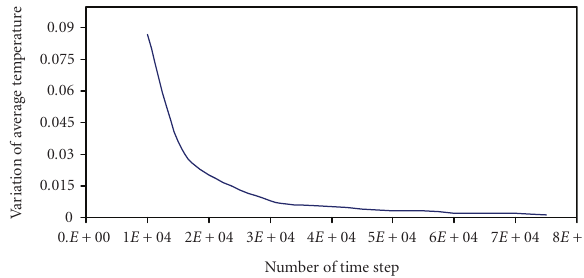
Figure 10: Temporal convergence analysis for the bundle